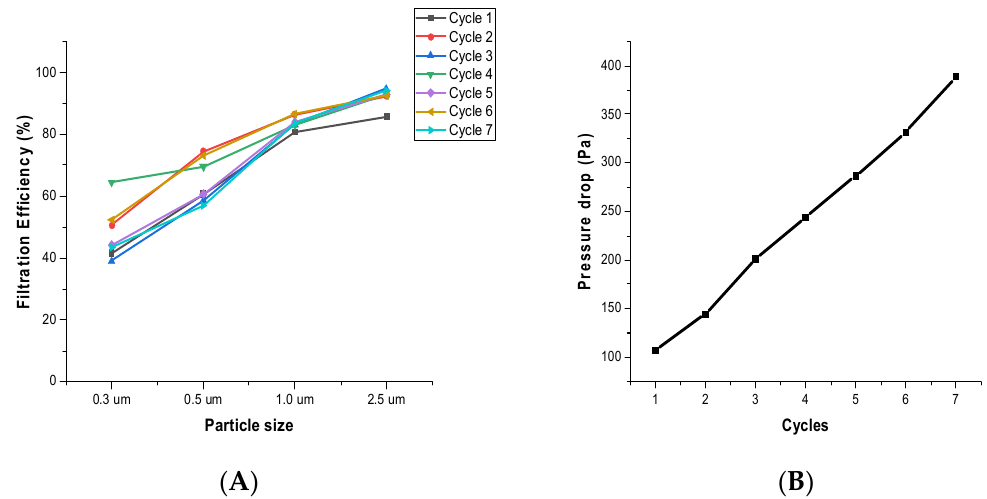
Figure 7. ( A ) Filtration Efficiency, and ( B ) pressure drop of the filter for seven cycles.